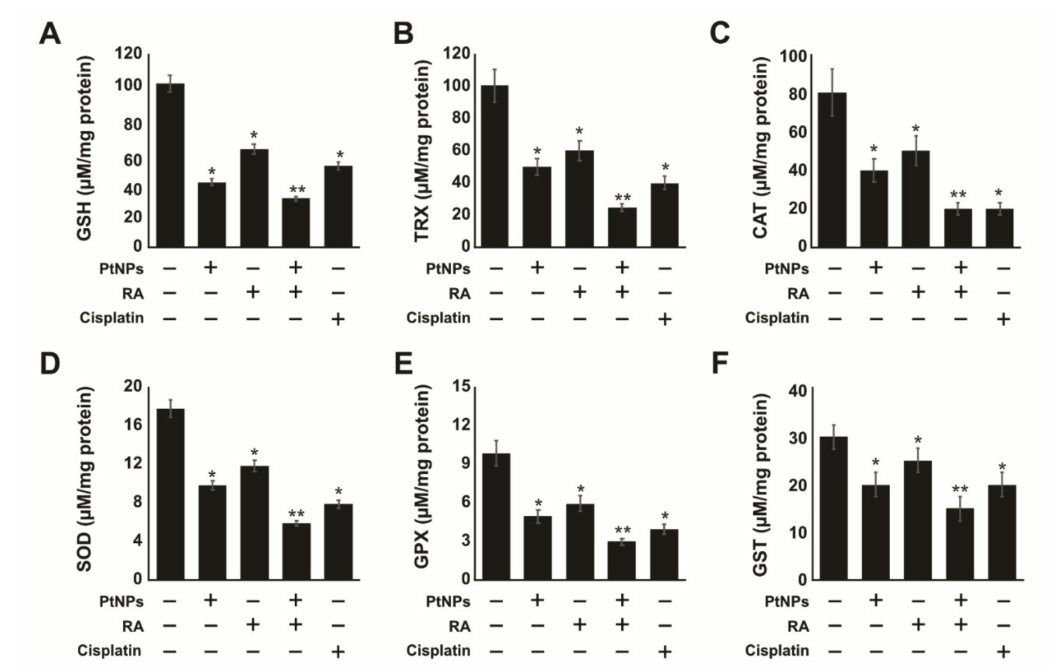
Figure 7. E ff ect of the combination of PtNPs and RA on antioxidant markers. SH-SY5Y cells were incubated with PtNPs (25 µ g / mL), RA (12.5 µ M), combination of PtNPs (25 µ g / mL) and RA (12.5 µ M), or cisplatin (6.5 µ M) for 24 h. After incubation, the cells were harvested and washed twice with ice-cold phosphate-bu ff ered saline solution. The cells were collected and disrupted by ultrasonication for 5 min on ice. Glutathione (GSH) concentration was expressed as µ M per mg of protein ( A ).